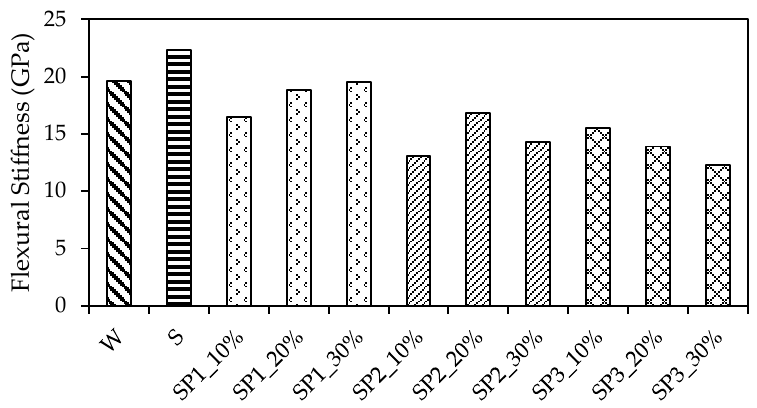
Figure 9. Comparison of flexural stiffness.